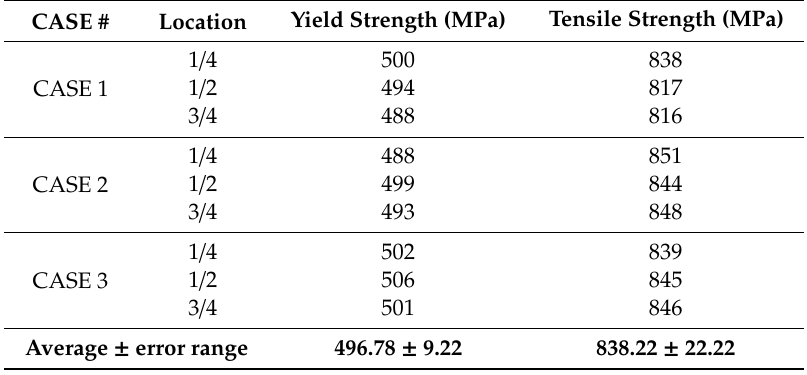
Table 6. The results of tensile test of welding part for each laser welding case.